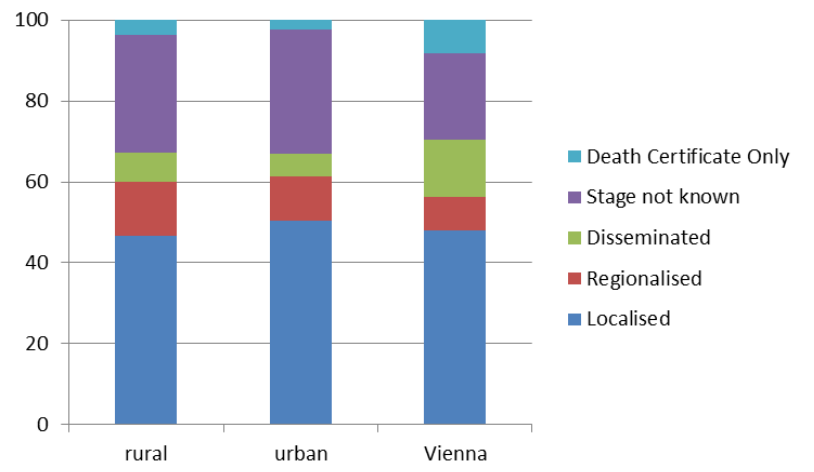
Figure 6. Distribution of melanoma cancer stages at time of diagnosis (in %): Comparison of different types of districts (rural, urban, and